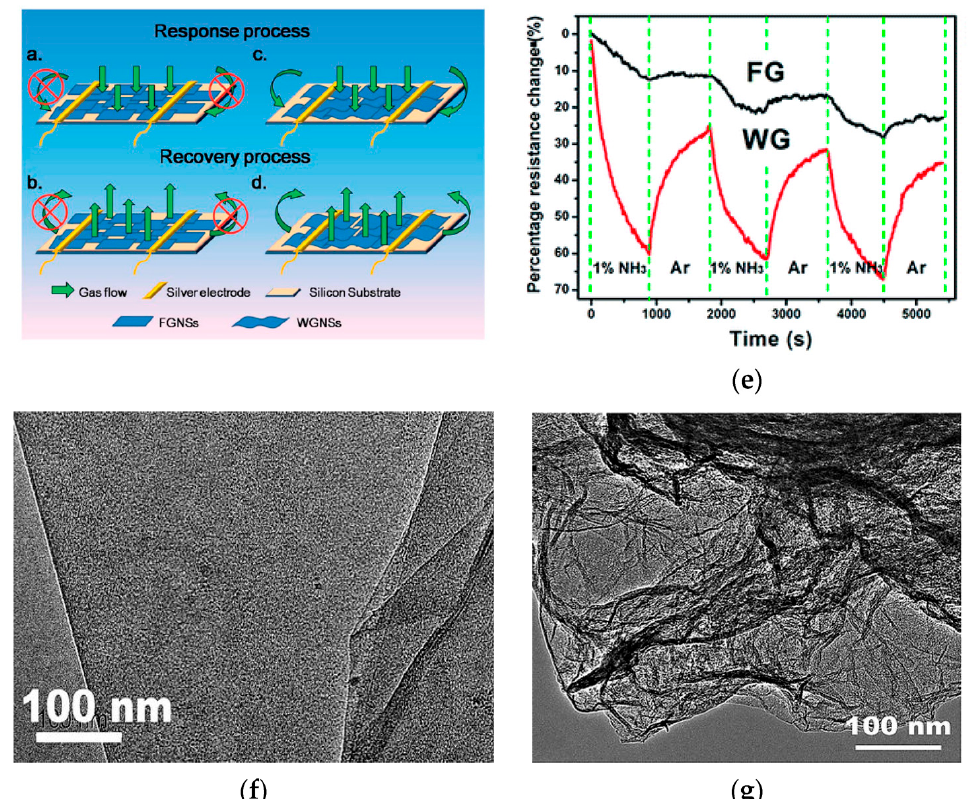
Figure 10. ( a ) Sensing of ammonia on flat rGO (FGNSs) and wrinkled rGO (WGNSs) nanosheets; ( b ) sensing properties of wrinkled and flat rGO nanosheets in 1% NH 3 ; ( c ) TEM image of flat rGO; ( d ) TEM image of wrinkled rGO [175]. Reproduced by permission of The Royal Society of